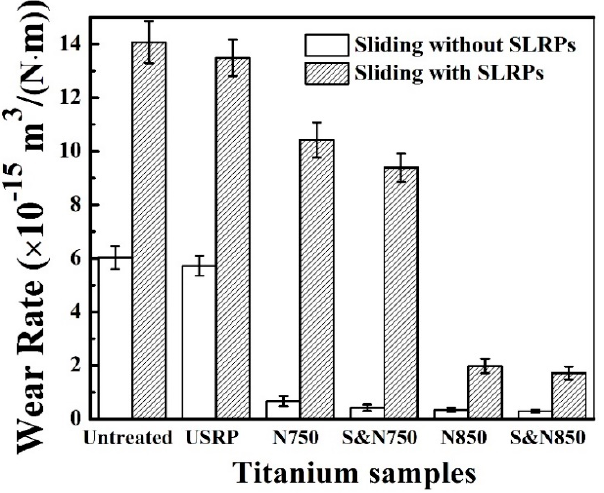
Figure 9. Wear rate of the Ti treated by USRP pre-treatment and plasma nitriding.